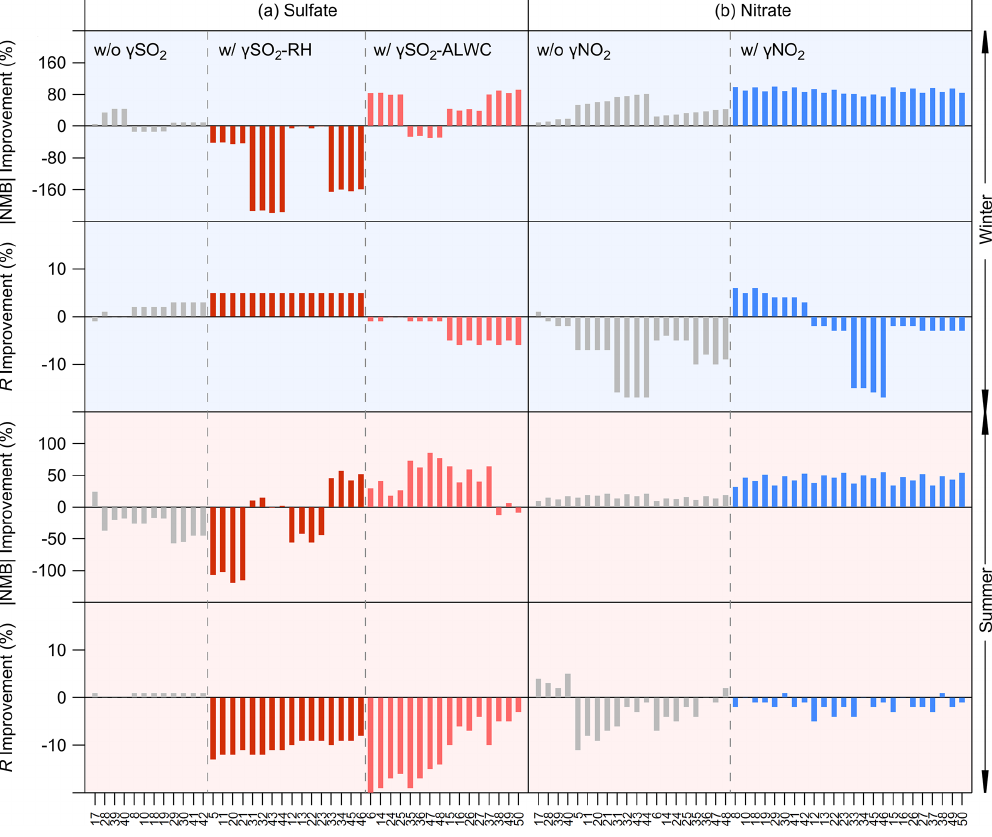
), 6 (with γ SO ), and 8 (reduced γ NO ) are 2 -RH 2 -ALWC 2